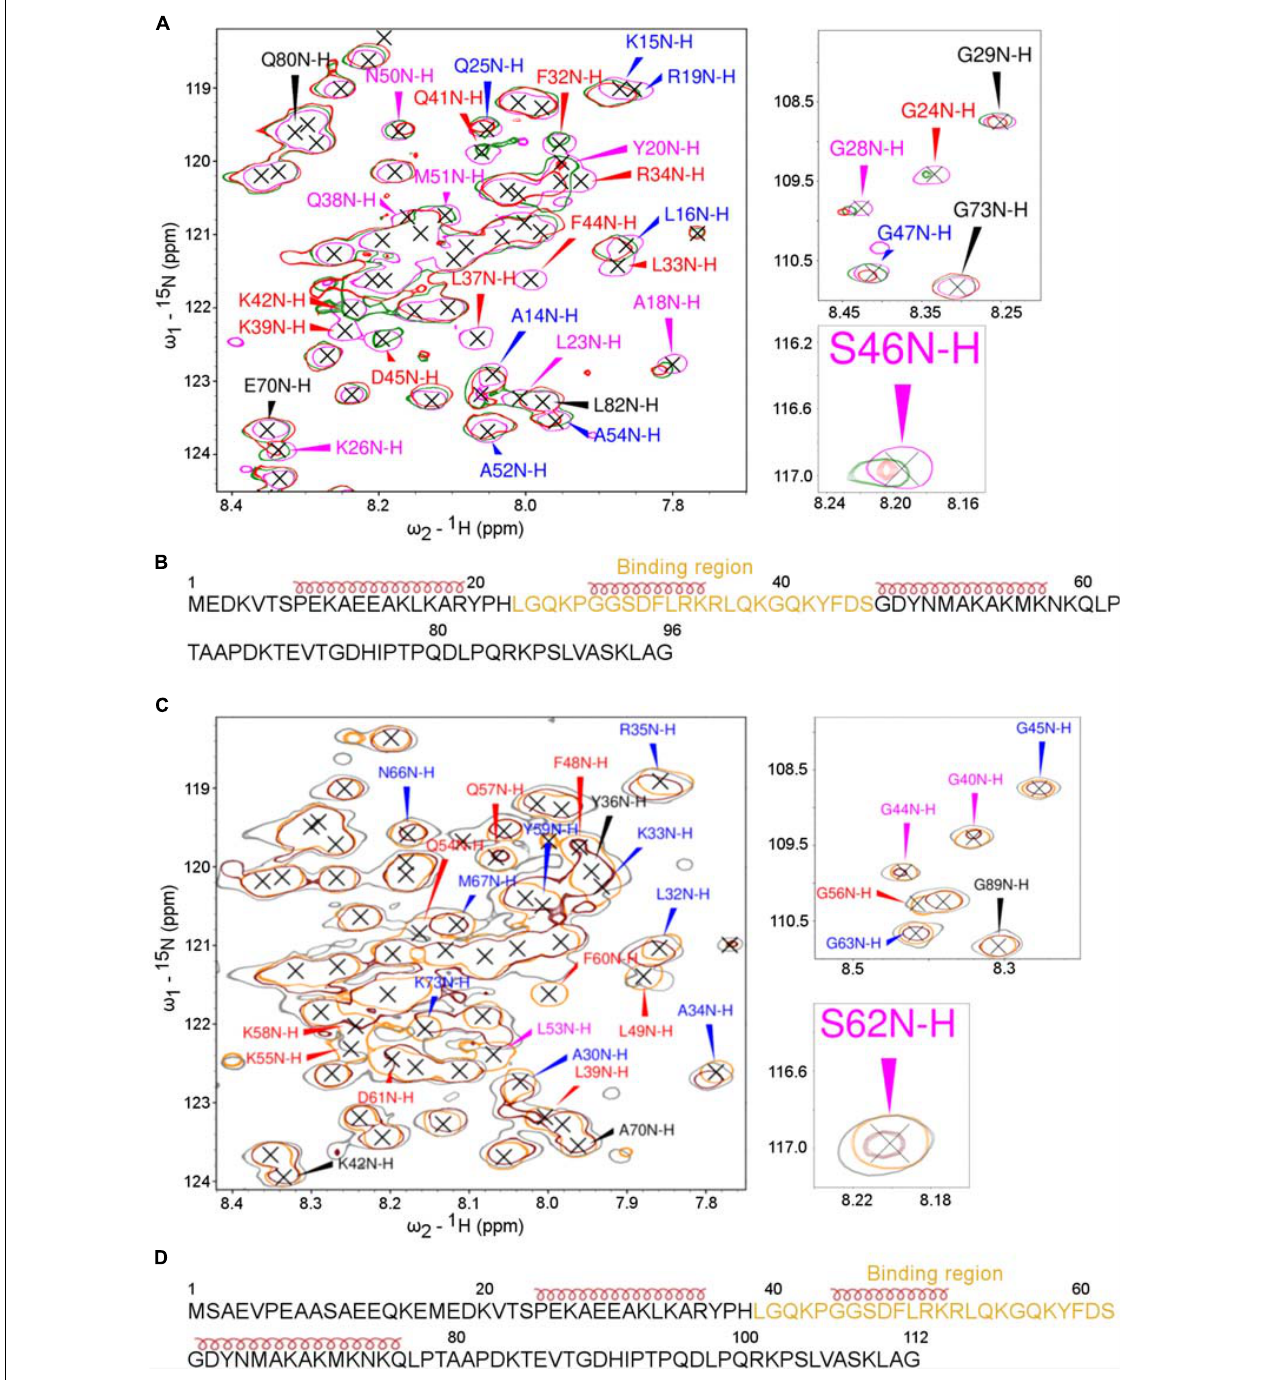
FIGURE 8 | The PP2A A-subunit binds to the 2nd transient α -helices. HSQC spectra of 15 N-labeled ARPPs collected before and after the addition of the PP2A A-subunit reveals the A-subunit interacts with the region that based on SSP calculations form a transient α -helices. (A) The overlaid of 15 N-HSQC of 15 N-labeled free ARPP-16 (magenta), 1:1 (green), 1:2 (red) ARPP-16: PP2A A-subunit. The NH cross peaks that broadened with 1:2 PP2A A-subunit-ARPP-16 are labeled red, whereas the cross peaks that shifted the most and exhibit significant line broadening are labeled with magenta and the NH correlations with small CSPs are labeled blue. Those NH cross peaks whose intensity and position remained intact are labeled with black color. (B) ARPP-16 sequence showing the epitope that interacts with the A-subunit of PP2A as well as the positions of transient α -helices obtained from SSP calculations are shown. (C) The overlaid of 15 N-HSQC of 15 N-labelled free ARPP-19 (orange), 1:1 (gray) and 1:2 (maroon) ratio with PP2A A-subunit. The effect to the addition of 1:2 ratio of A-subunit into ARPP-19 are labeled similarly as in panel (A) . (D) ARPP-16 sequence showing the region that interacts with the A-subunit of PP2A as well as the positions of the transient α -helices obtained from SSP